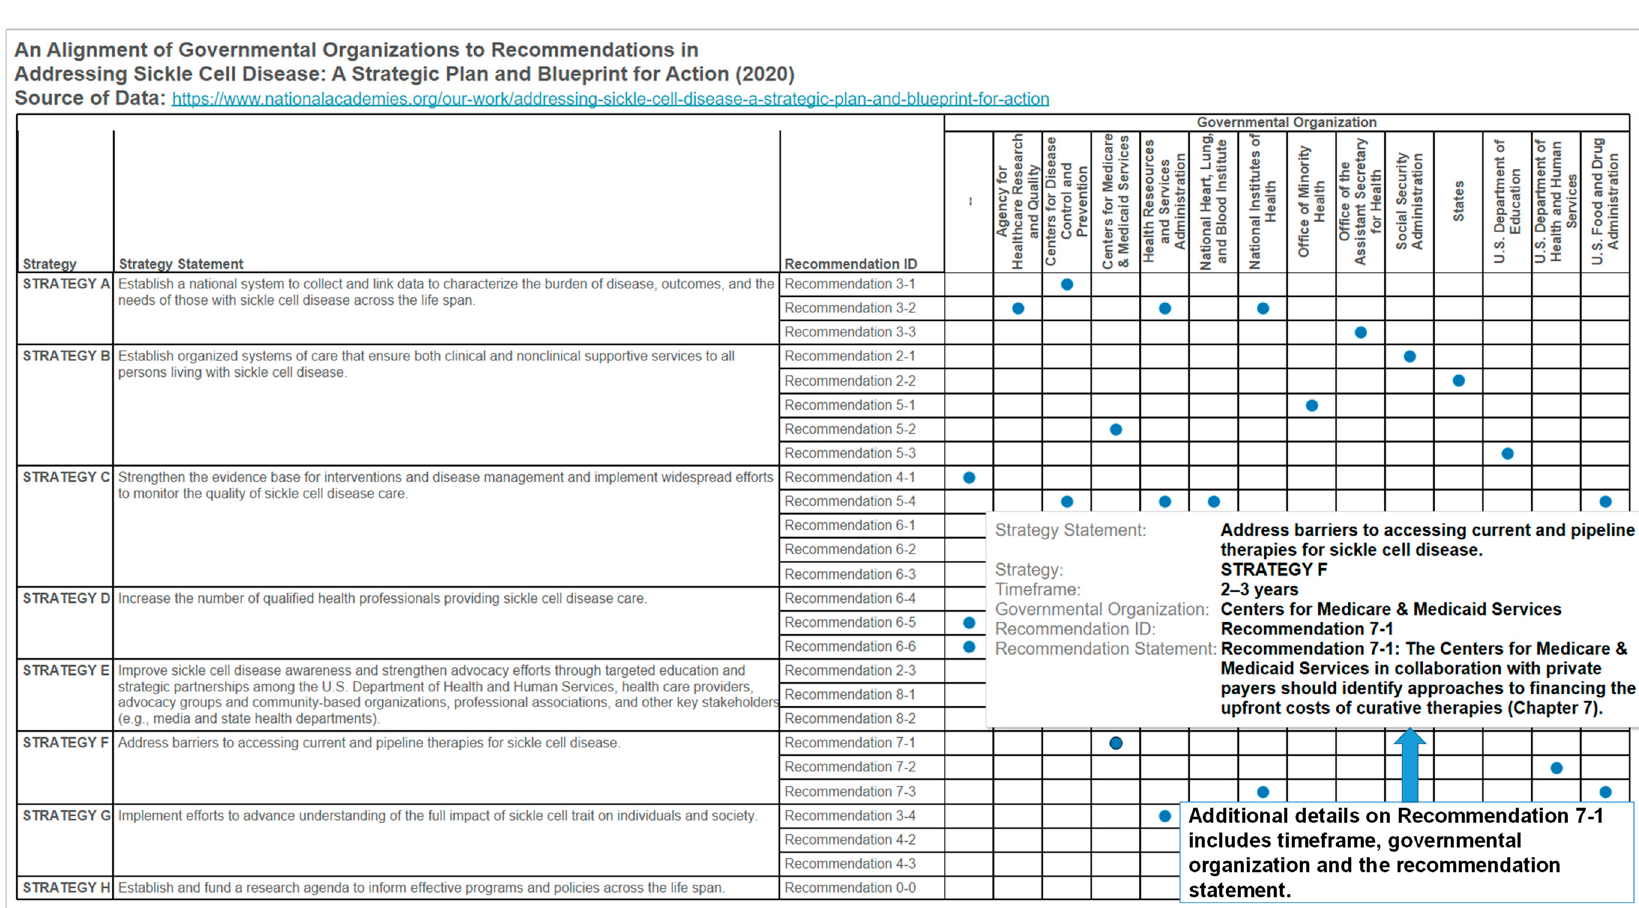
Figure 10. An example design of an interactive visual representation that allows for integrating and comparing strategies and expert recommendations on clinical and public health aspects of sickle cell disease. In this example, we highlight the alignment of governmental organizations to strategies such as financing the upfront costs of curative therapies by the Centers for Medicare & Medicaid Services. The interactive analytics resource could function as a decision aid for identifying potential funding sources for sickle cell disease initiatives in the United States.